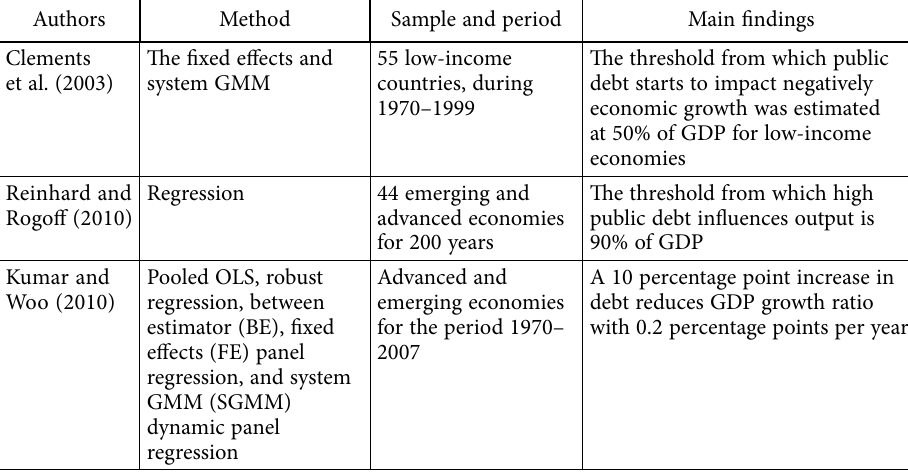
Table 1. Literature review, relation debt-economic